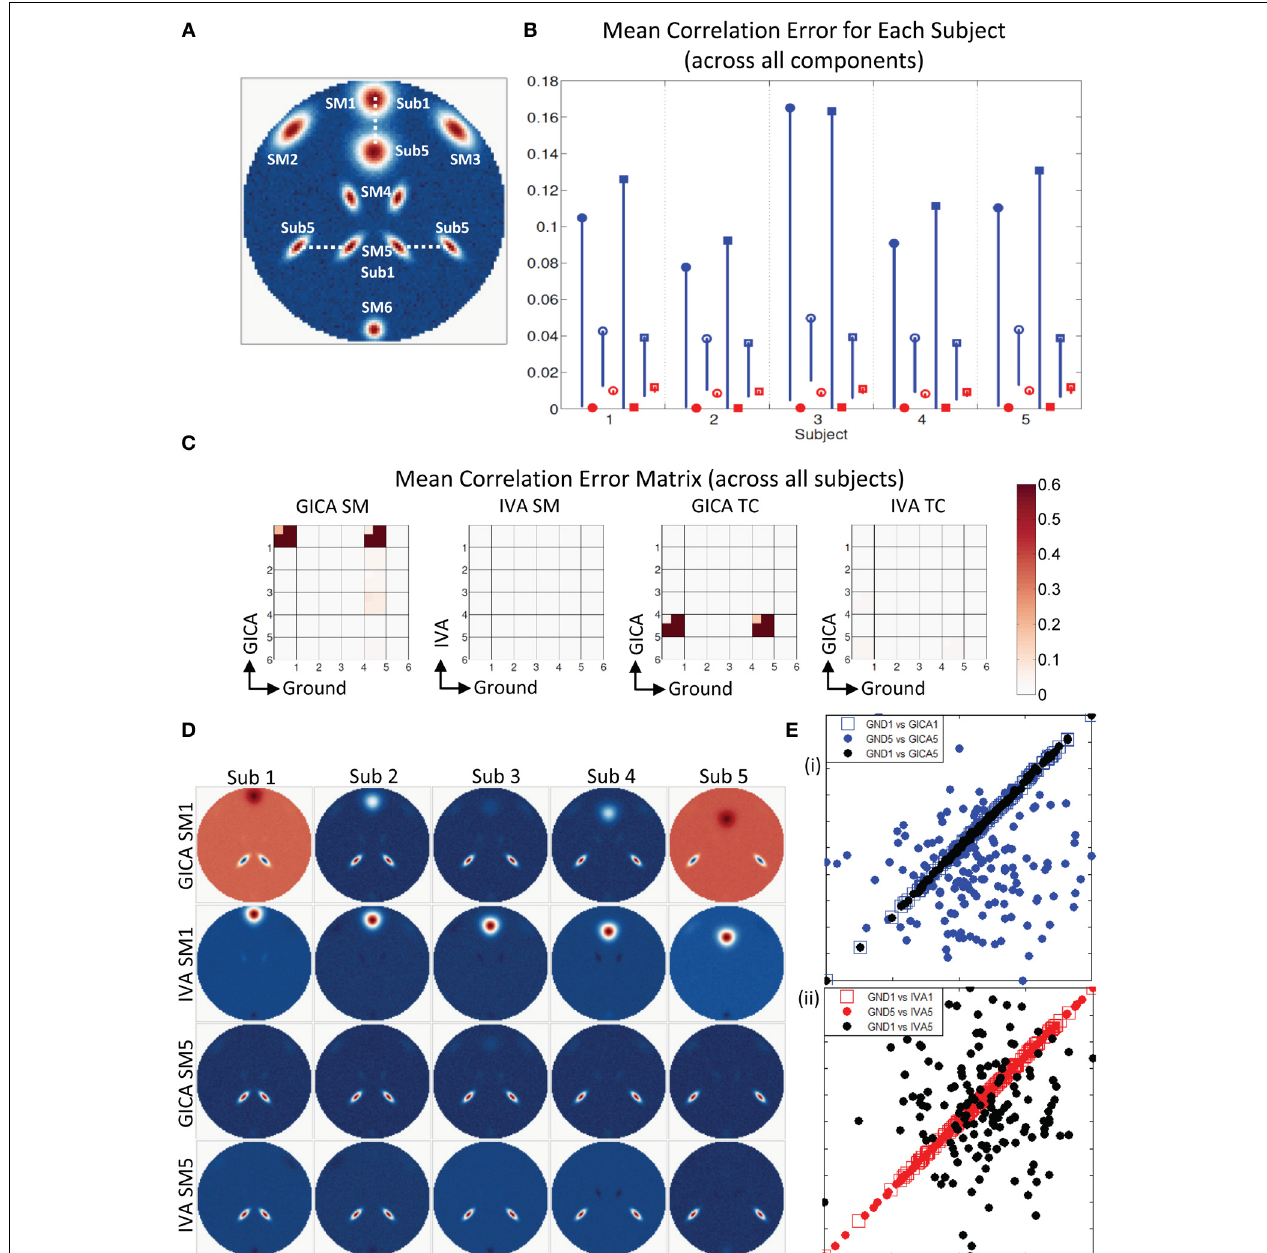
FIGURE 7 | Estimation when SM1 and SM5 are varied across subjects. (A) SM1andSM5arespatiallyvariedforallsubjects.LocationsofSM1forSubjects 1 and 5 are shown and SM1 for other subjects are equally spaced between those locations. (B) Mean correlation errors across all components, presented for each subject separately. Mean errors are in blue for GICA and in red for IVA. Diagonal elements of the correlation error matrix are in filled shapes and non-diagonal in unfilled shapes. SMs are presented in circles and TCs in squares (see “Definition of Result Evaluation Parameters” section for their definitions). All IVA mean correlation errors are less than 0.02. All GICA errors are much higher with large error bars. For clarity of lower error values, only the lower bounds of the error bar are presented. (C) Mean correlation error matrix between ground and estimates is calculated for all subjects and the mean and